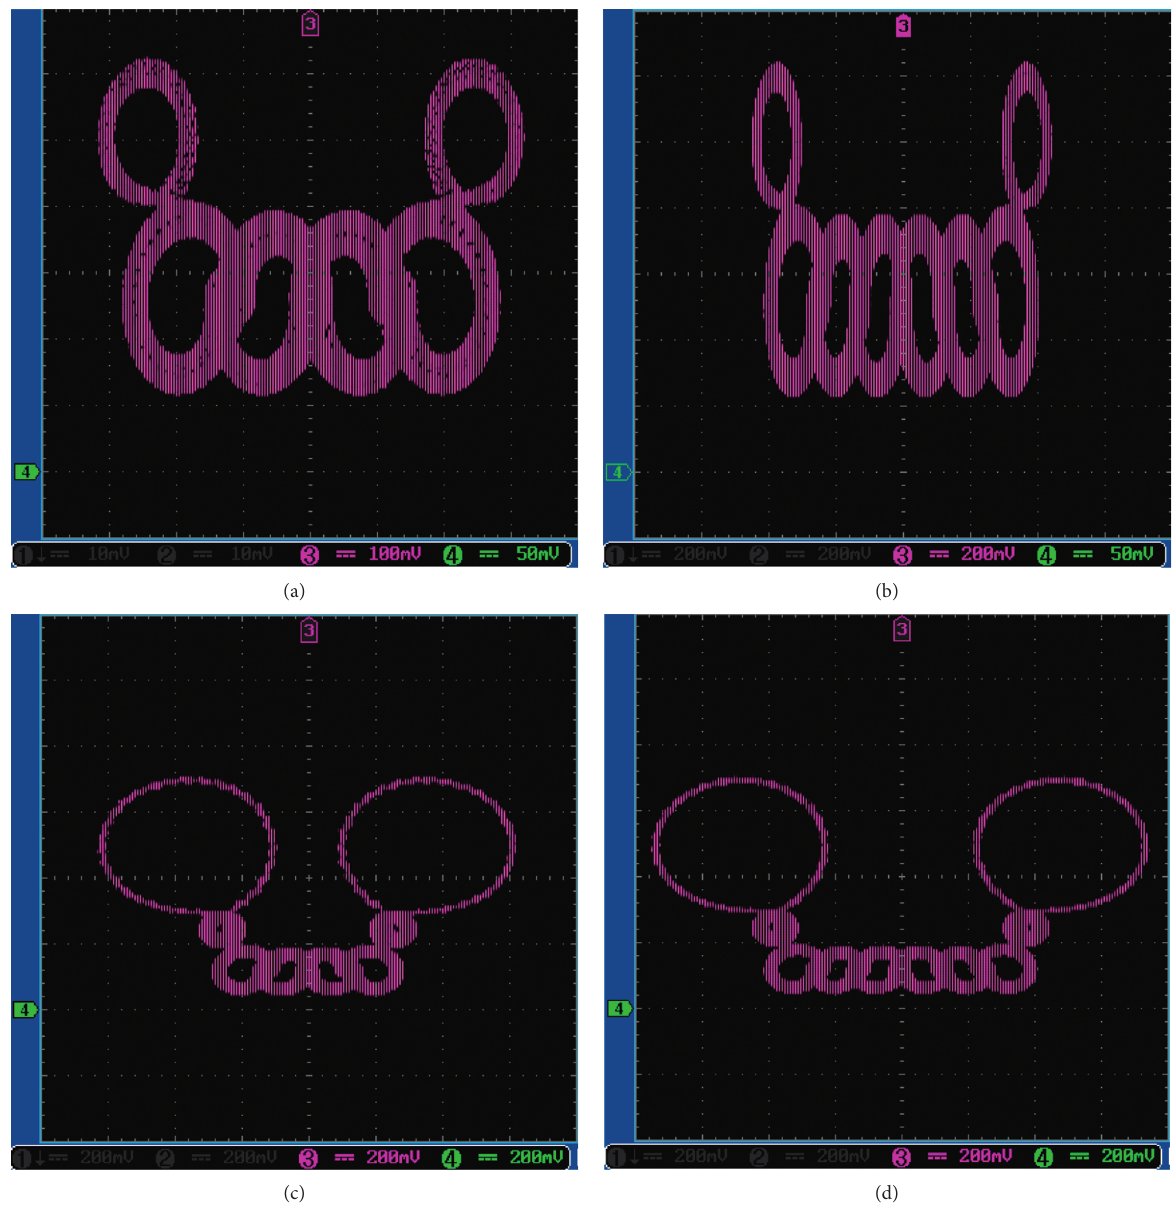
Figure 4: Experimental results of multiscroll chaotic systems: (a) six-scroll chaotic attractors for m � 1 and n � 1; (b) eight-scroll chaotic attractors for m � 2 and n � 1; (c) eight-scroll chaotic attractors for m � 1 and n � 2; (d) ten-scroll chaotic attractors for m � 2 and n �